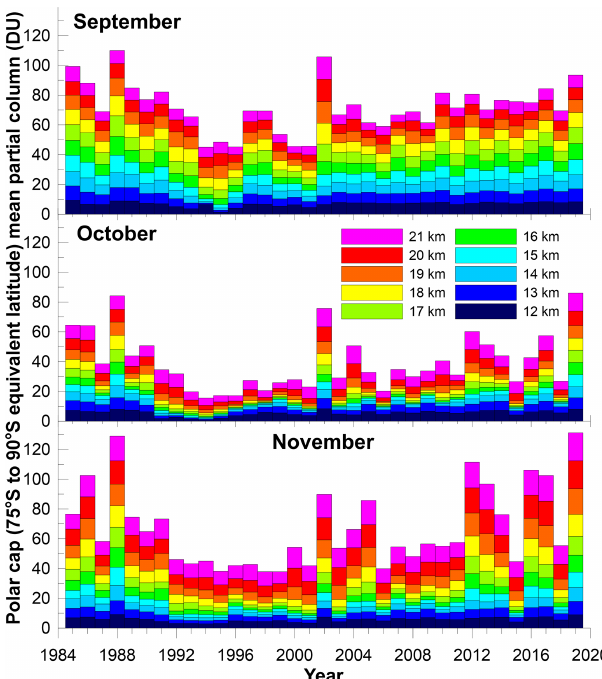
Figure 9. Monthly mean, polar cap mean (75 ◦ to 90 ◦ S equivalent latitude), 1km thick partial ozone columns for September, Octo- ber, and November (Southern Hemisphere spring) of each year from 1985 to 2019.